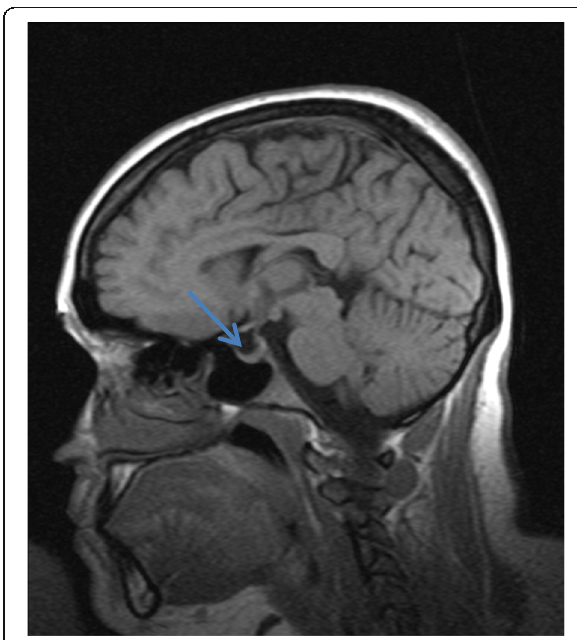
Fig. 7 MRI brain T1 sequence sagittal view of a 24-year-old lady showing empty sella turcica grade IV and posterior displacement of pituitary stalk